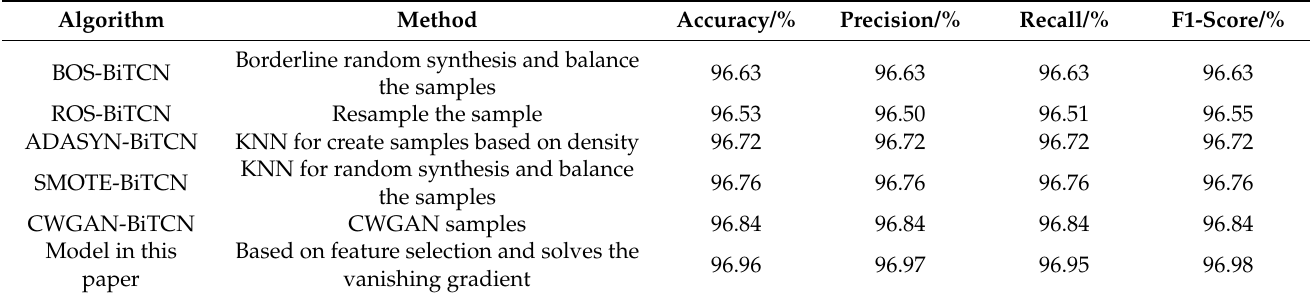
Table 6. Detection results under the influence of enhanced algorithms on DataCon